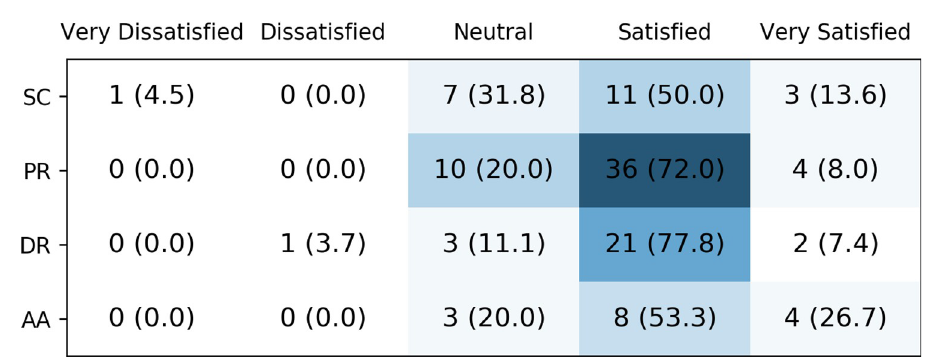
Fig 11. Healthcare providers’ overall satisfaction with the different CDS tools. SC: Safety Code cards, PR: printed reports, DR: digital reports, AA: automatic alerts.